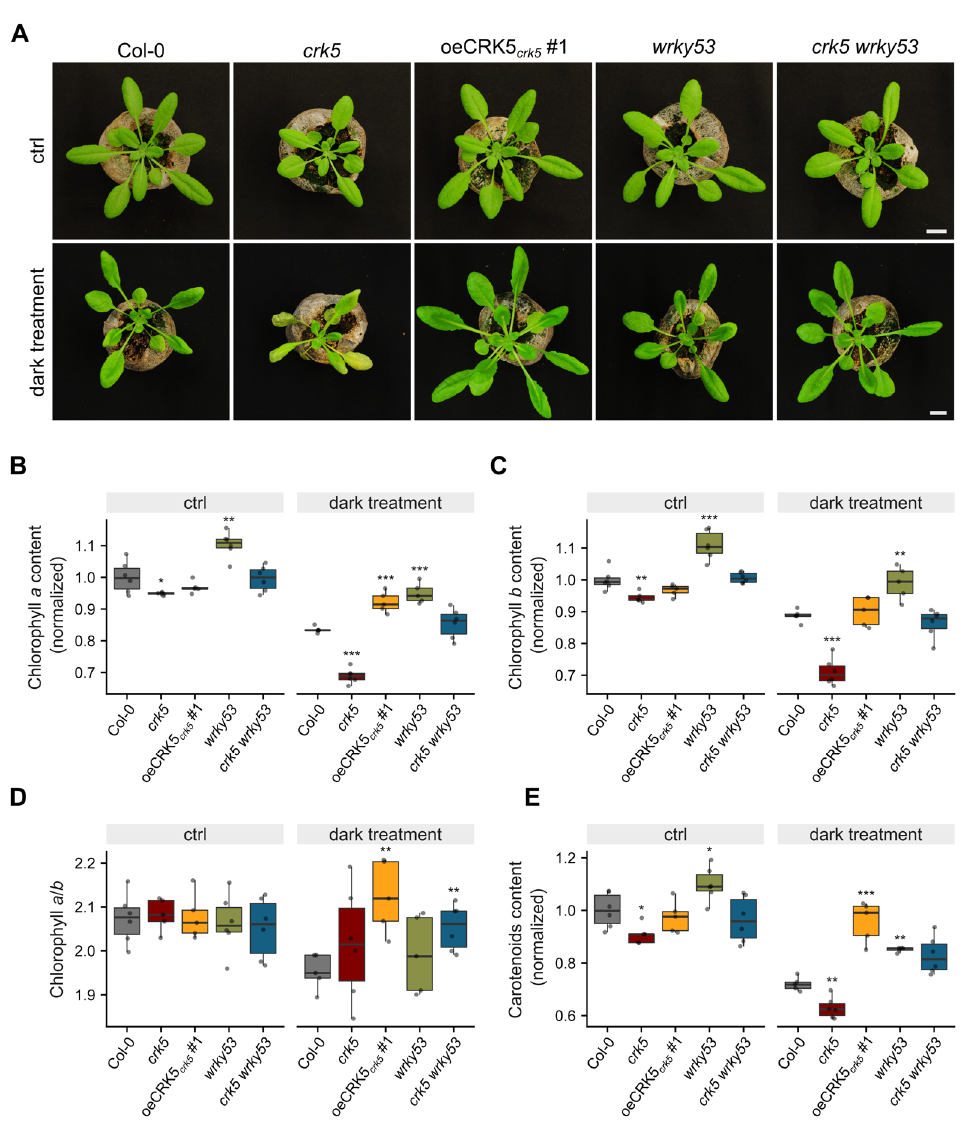
Figure 3. ( A ) Morphological phenotype of dark-induced senescence in the analyzed genotypes. Photographs were taken of plants growing under ambient light (120 µ mol m − 2 s − 1 ) conditions and then transferred for four days to continuous darkness. White scale bars indicate 1 cm ( B – E ) Analysis of pigment content changes under continuous darkness conditions. The figures show the level of chlorophyll a ( B ), chlorophyll b ( C ), chlorophyll a / b ratio ( D ), and carotenoids ( E ). Mean values ( ± SD) were derived from 6 plants ( n = 6). Dots represent individual observations. Asterisks indicate a significant difference according to the t -test at level p < 0.001 (***), p < 0.01 (**), and p < 0.05